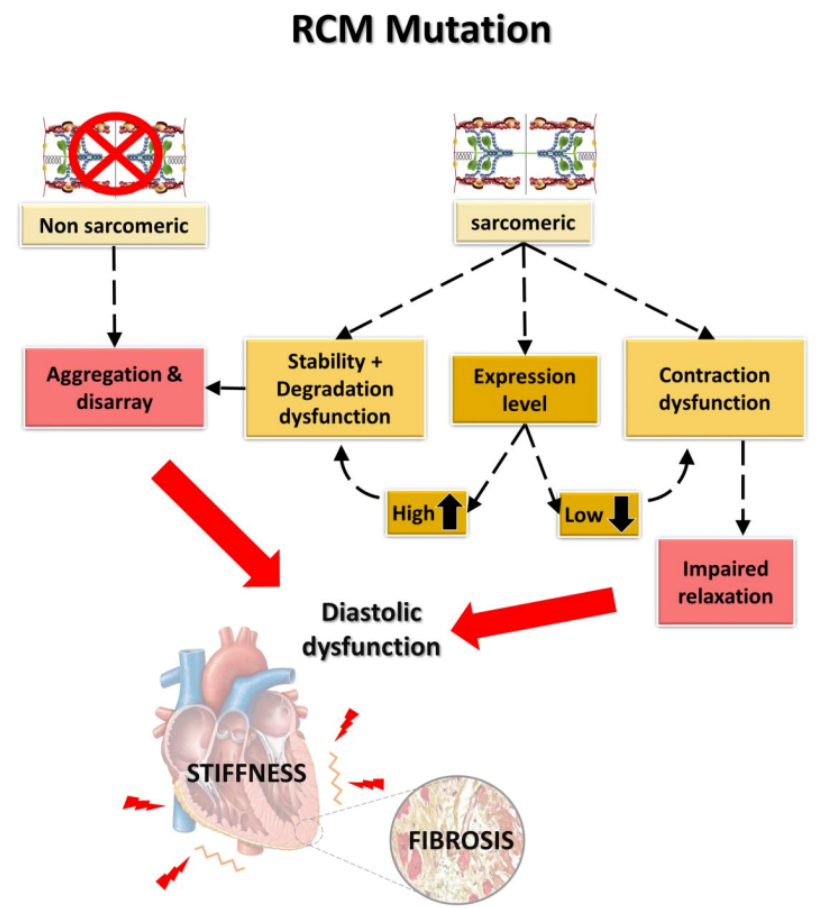
Figure 6. Factors leading to the development of the genetic RCM. While non-sarcomeric mutations lead to aggregations and promote cytoskeletal and sarcomeric disarray, sarcomeric mutations may affect the cardiac function in different ways, depending on their expression levels, stability, tendency to aggregate and to induce contractile dysfunction. Both finally lead to diastolic dysfunction and increased stiffness. The figure was created using PowerPoint (Microsoft).